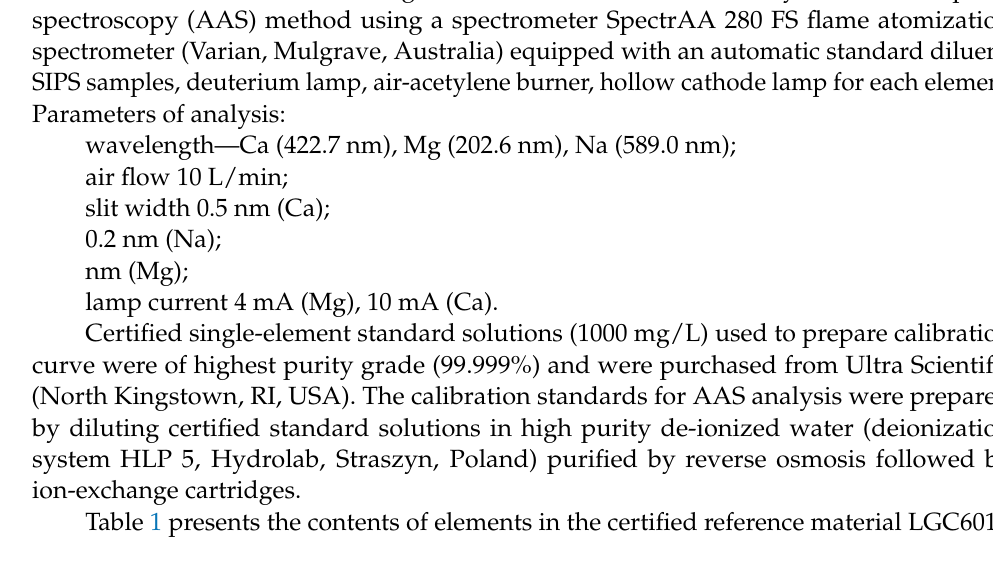
Table 1. The content of elements in the certified reference material LGC6019 and validation parameters obtained during